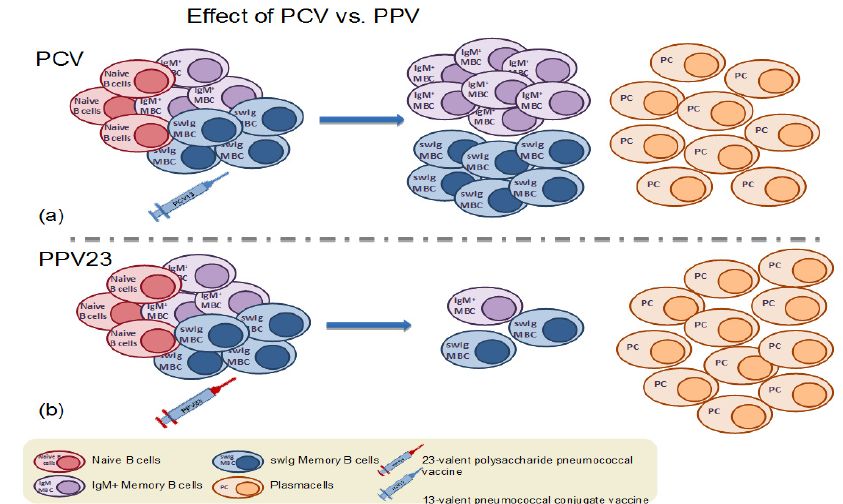
Figure 3. ( a ) Immunization with a dose of pneumococcal conjugate vaccine results in the formation of antigen-specific memory B cells and plasma cells. ( b ) In contrast, immunization with the 23-valent plain polysaccharide vaccine (PPV23) results in the depletion of the pre-existing antigen-specific memory B cell population.